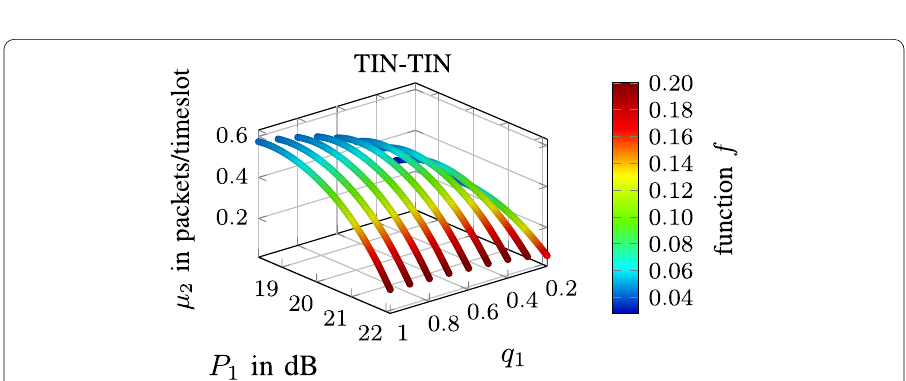
Fig. 6 ( µ 2 , function f aw ) versus ( q 1 , P 1 ), under congestion-aware randomized policy in TIN-TIN. The rest of the parameters are the following: (cid:31) 1 = 0.1 , γ 1 = − 4.2dB , γ 2 = − 6.4dB , α = 2.2 , β = 41dB , P J = 23dB , q 2 = 0.4 , B = 6 packets, P max = 23dB , d 2 = 14.6m , and d 12 = 10m . In TIN-TIN, d 1 =